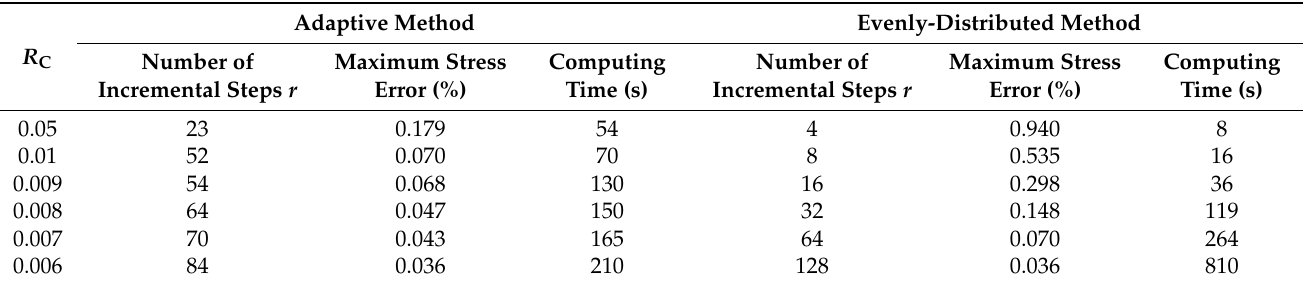
Figure A1. Location distribution of the adaptive load incremental steps in LIM. ( R C = 0.05). Table A1. Comparisons of number of incremental steps and maximum stress error between adaptive method and evenly-distributed method.